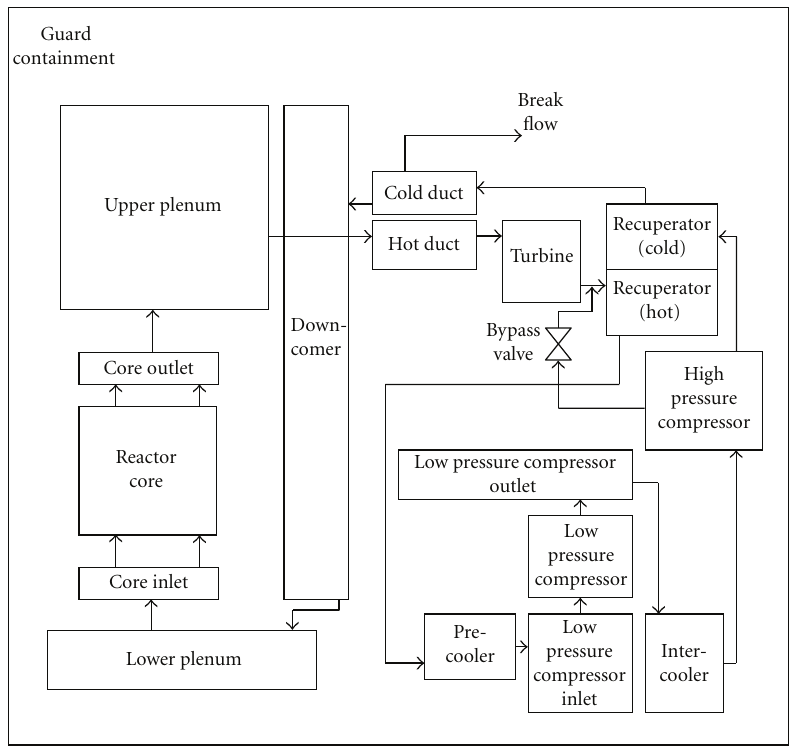
Figure 7: Reactor vessel and power conversion unit volume arrangement.